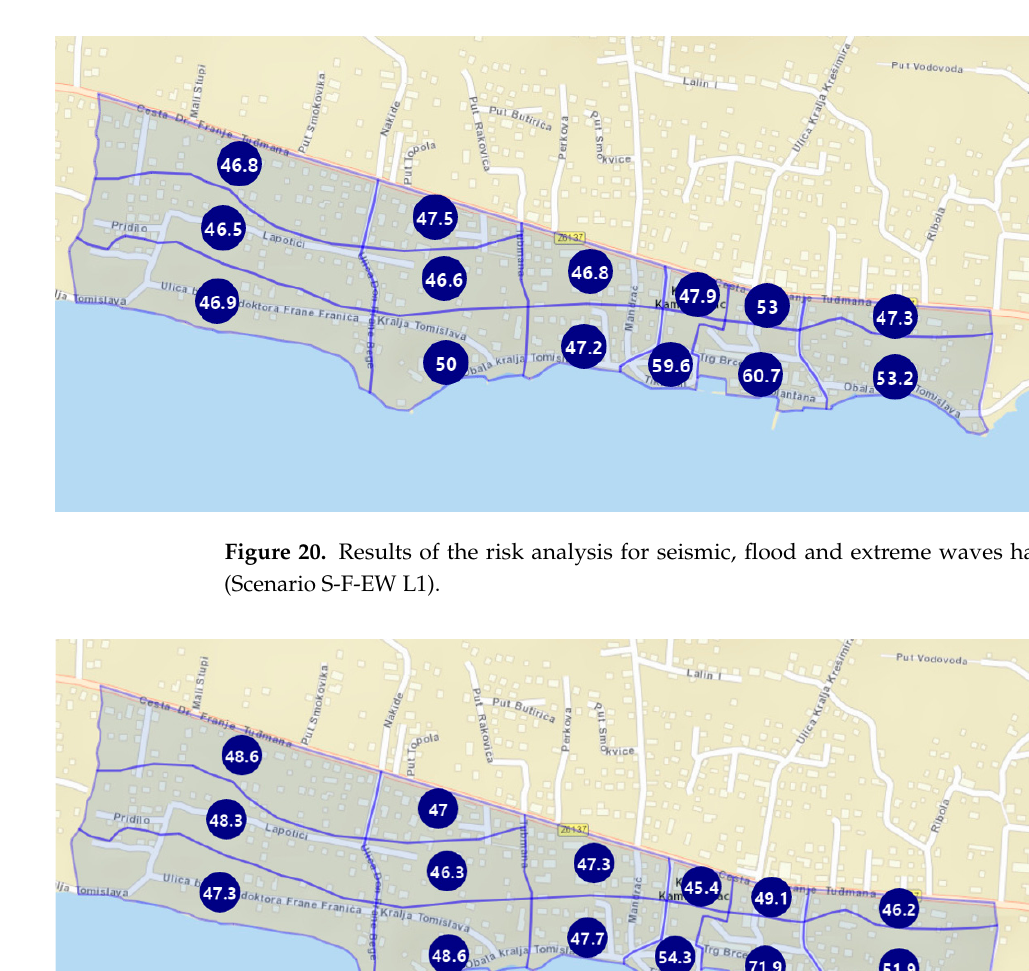
Figure 20. Results of the risk analysis for seismic, flood and extreme waves hazards for Level 1 (Scenario S-F-EW L1).